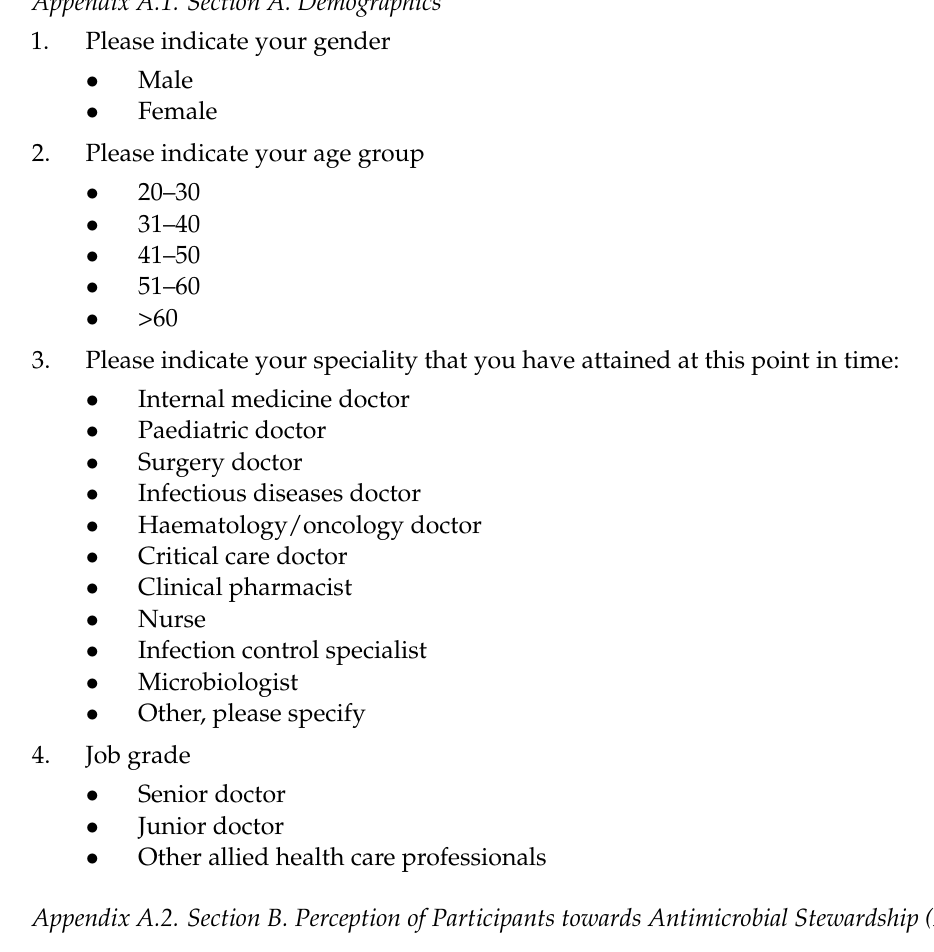
Table A1. Perception of Participants towards Antimicrobial Stewardship